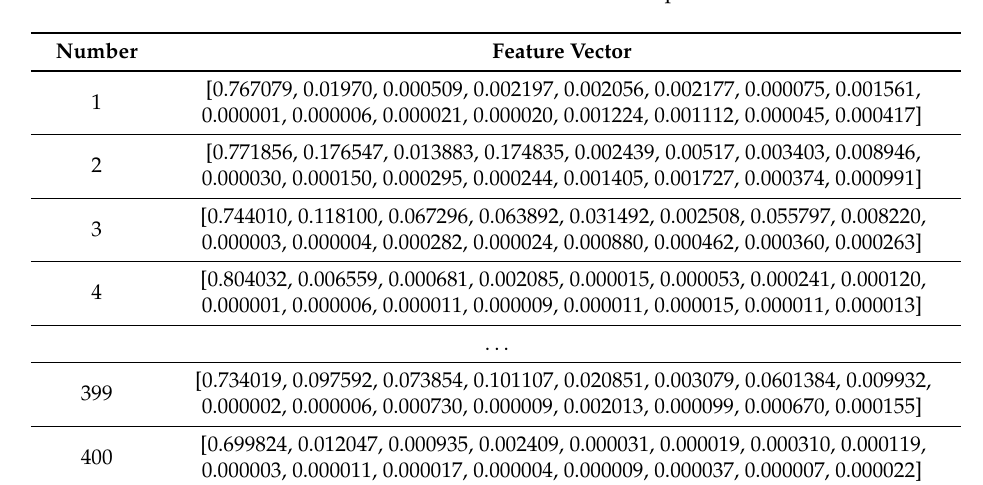
Figure 7. Wavelet packet node coefficients. Table 2. Feature vectors of the 300 samples.